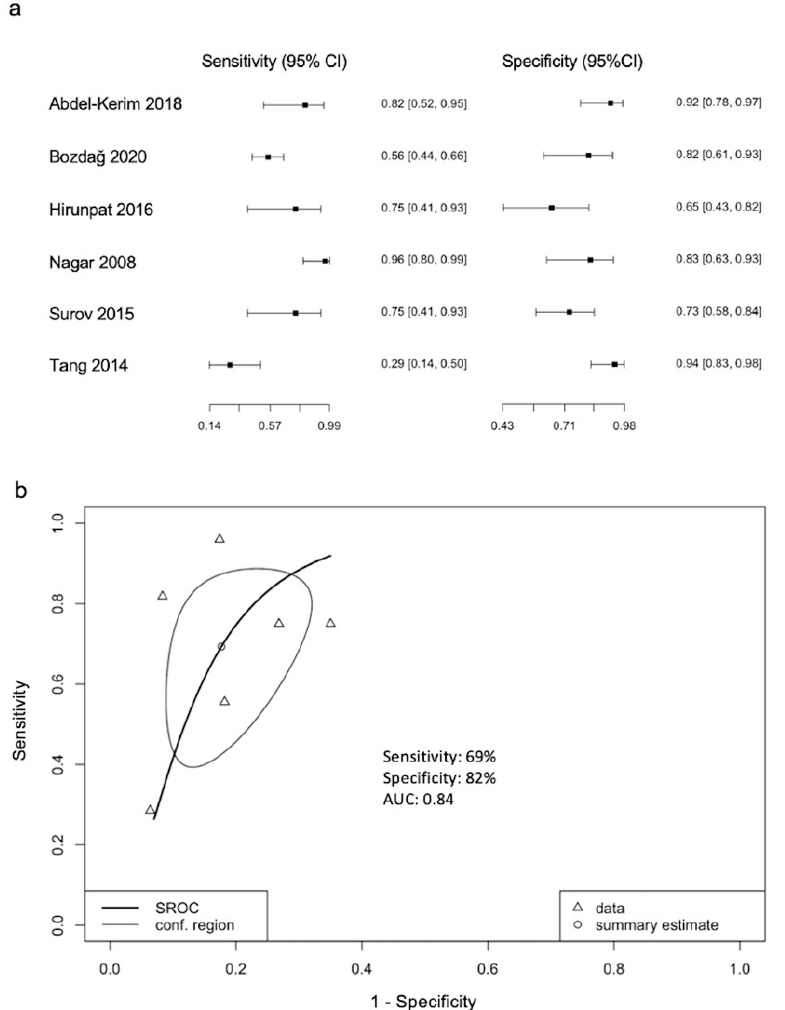
Figure 4. The ( a ) forest plot and ( b ) summary ROC curve in diagnostic test accuracy of ADC threshold values for differentiation between LGMs and HGMs. Pooled sensitivity of 69%, specificity of 82%, and AUC of 0.84 are obtained.